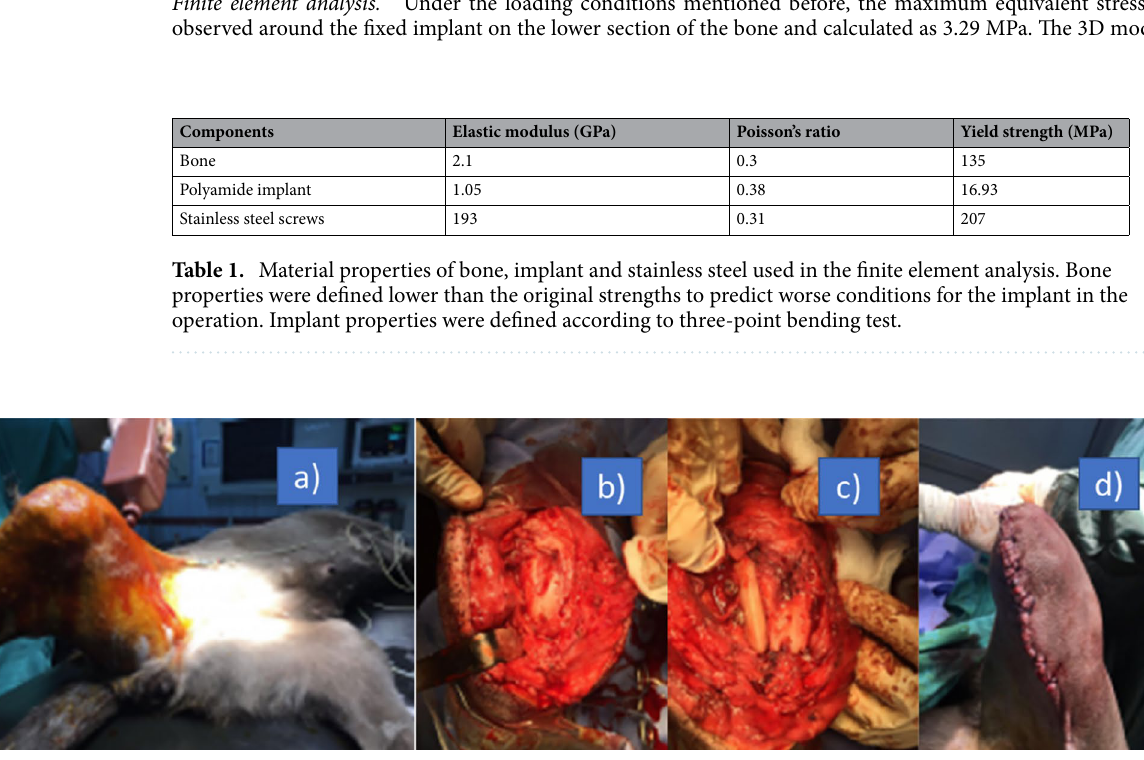
Figure 4. Preoperative photograph ( a ), deformed lateral femoral condylus ( b ), overformed polyamide patient specific implant fixation with two 3,5 mm cortical screws ( c ), postoperative photograph of the dog ( d